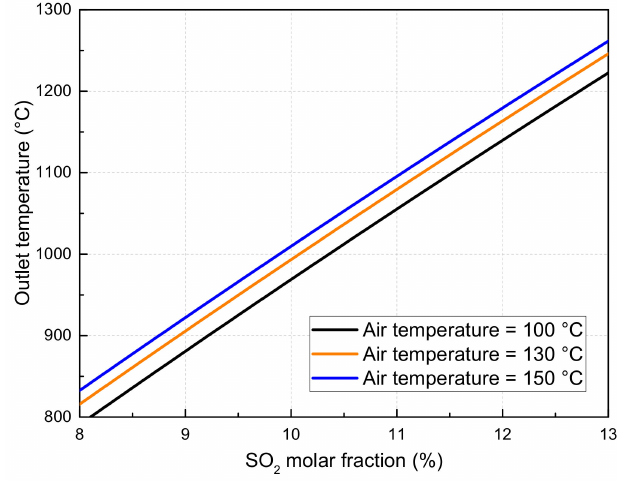
Figure 12. Relationship between the furnace outlet temperature and the SO 2 molar